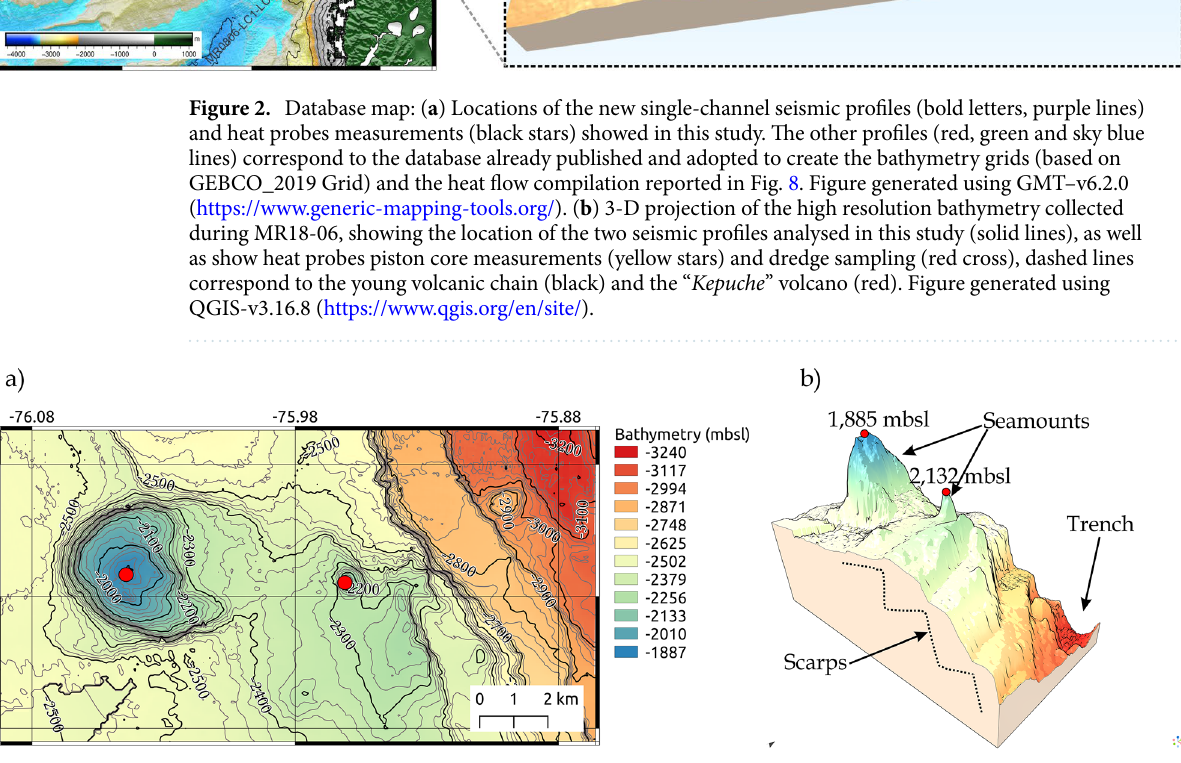
Figure 3. Regional setting of the seamounts near to the CTJ. Bathymetry collected during the expedition MR08-06 and MR18-06 Leg2. ( a ) Contour map of the study area and the most important seamounts identified in the oceanic crust. The red dots correspond to the summit in meters below the sea level (mbsl); ( b ) 3-D view of the identified seamounts and scarp-morphology of the west axial rift (dashed lines). Figures generated using QGIS-v3.16.8 (https:// www. qgis. org/ en/